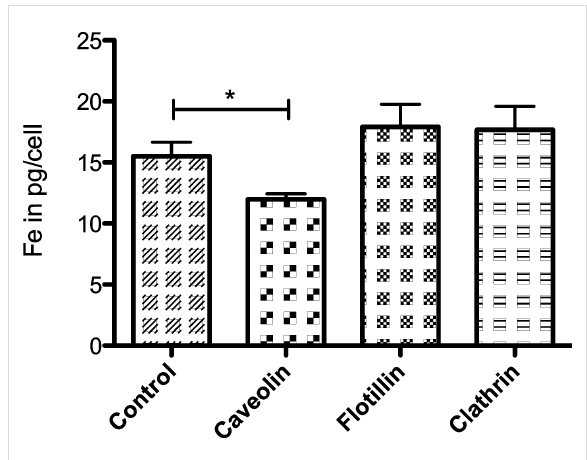
Figure 5: Iron content of control and transfected HeLa cells in pg/cell after 24 h incubation with carboxylated SPIONs; target proteins: Caveolin-1, Flotillin-1, Clathrin (iron concentration 50 µg/mL, error bars: SEM, n = 3).